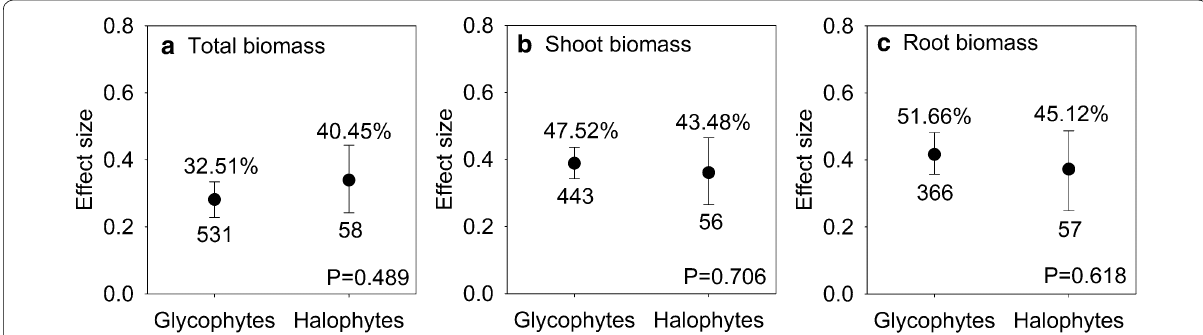
Fig. 1 Responses to salt stress of total biomass ( a ), shoot biomass ( b ) and root biomass ( c ) in mycorrhizal halophytes and mycorrhizal glycophytes. Error bars represent 95% confidence intervals (CIs). Back-transformed effect sizes are shown above the bars. The numbers of studies are shown under the bars. Inoculation effects were considered significant when the 95% CIs did not overlap with zero. The P values for each panel reflect the significant differences between halophytes and glycophytes